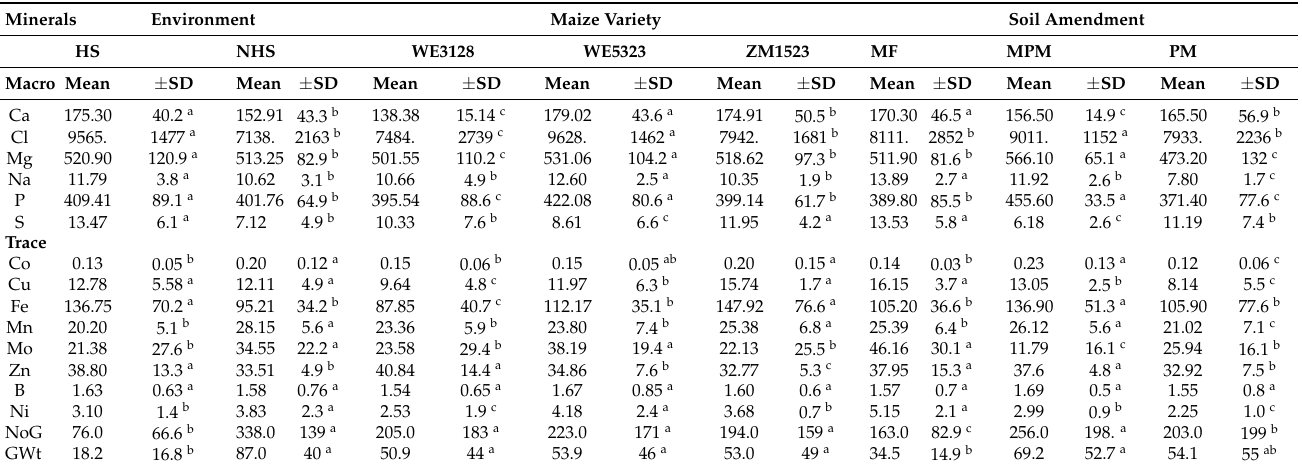
Table 2. The main effects of growth environment, variety, and soil amendment on the maize grain yield and mineral concentrations ( µ